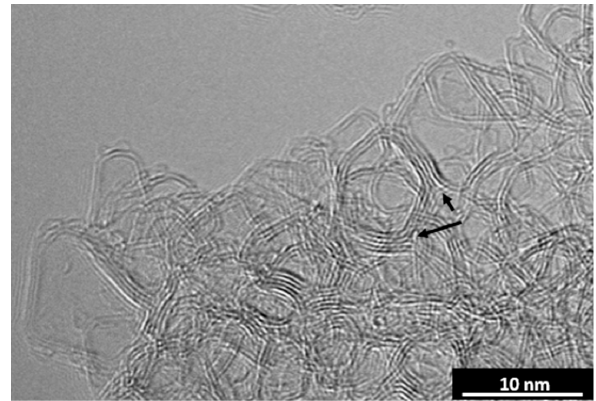
Figure 16. TEM micrograph of sucrose char after 5 s at 2600 °C.